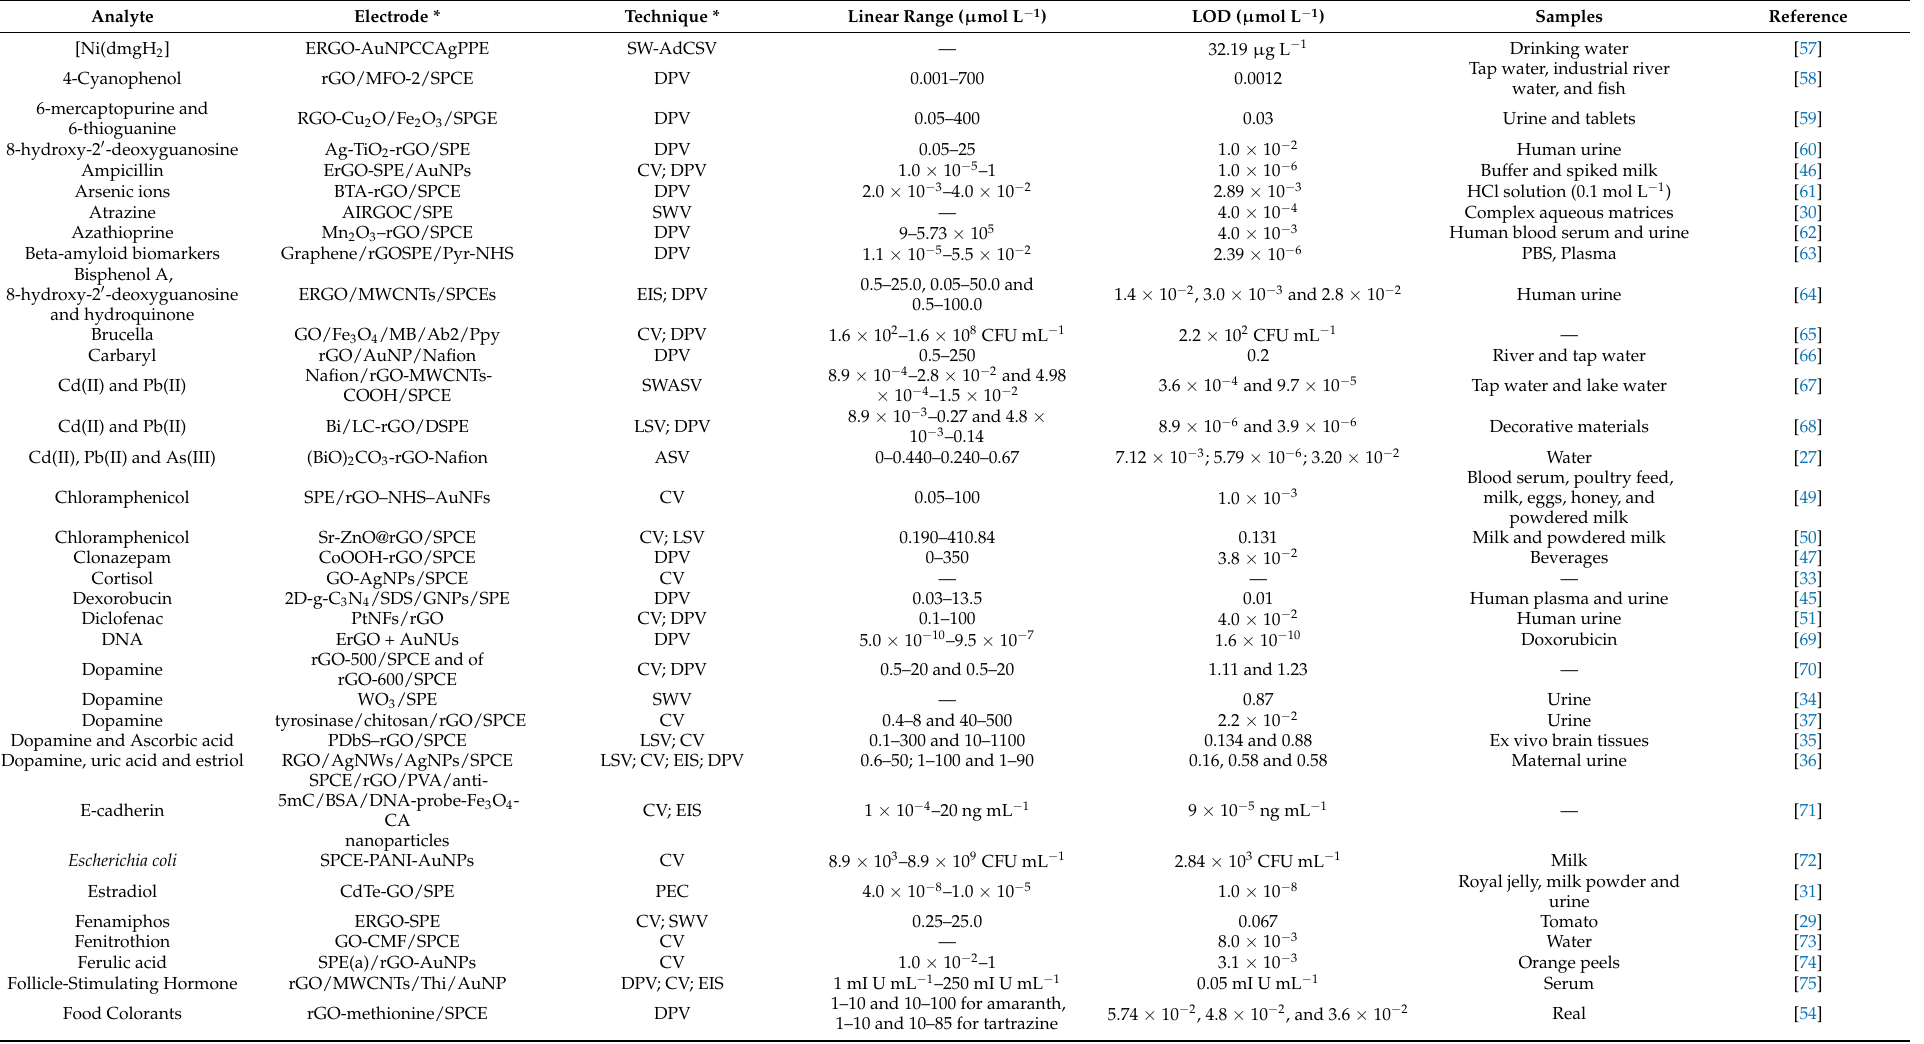
Table 1. Electrochemical sensors based on graphene